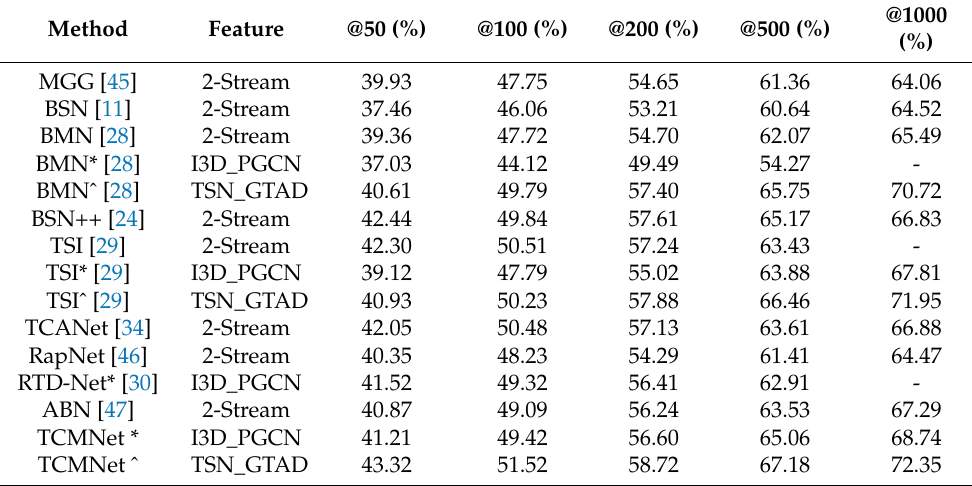
Table 2. Comparison between TCMNet and other state-of-the-art temporal action proposal generation methods on THUMOS14 in terms of AR@AN. Results with “*” are reported based on I3D_PGCN features and results with “ˆ” are reported based on TSN_GTAD features.